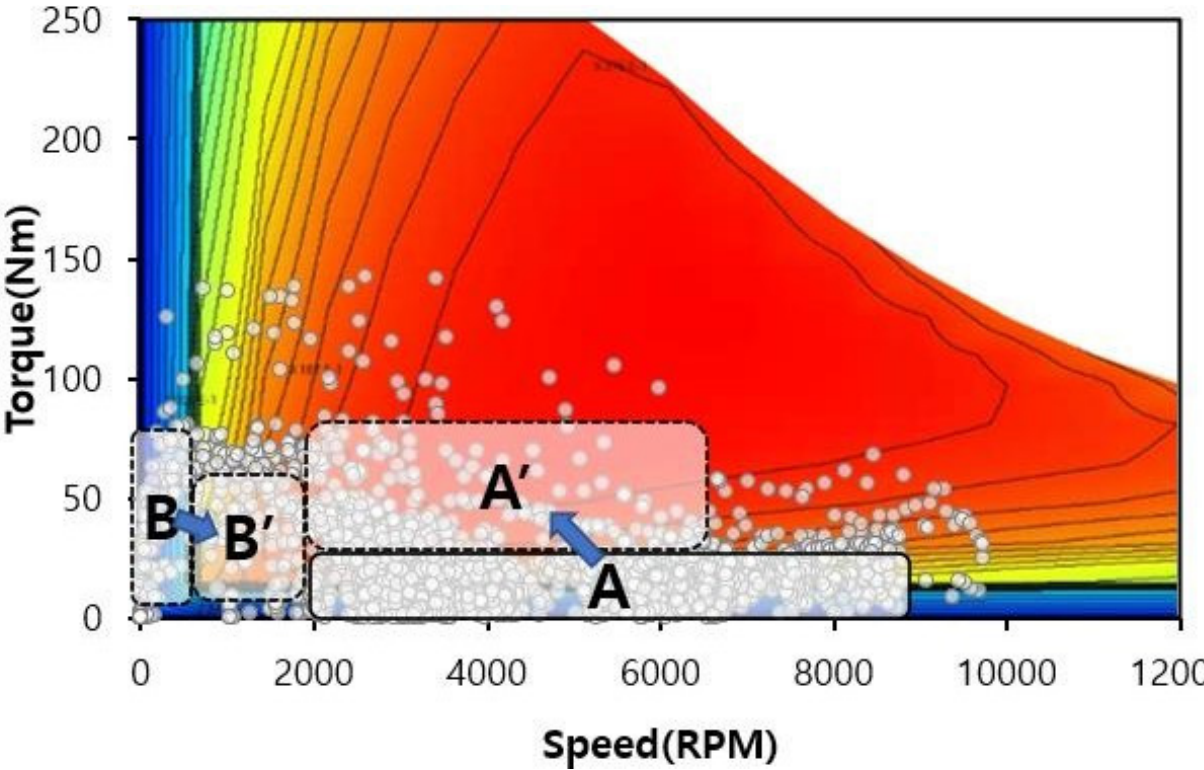
Figure 11. Strategy of optimal shift pattern in EV with CVT for improving the driving distance. Table 5 lists the shift range according to the deceleration factor variable for the [A–A (cid:48) ] movement and the deceleration ratio of the single reducer for its implementation. Based on the deceleration ratio (9.7:1), the lowest shift ratios of the CVT were 1/1, 5, 1/2, 5, 1/3, and 1/4. The highest shift ratio of the CVT was derived by multiplying the CVT span by 6. Table 5. Comparison of CVT shift range and single-reducer ratio according to deceleration